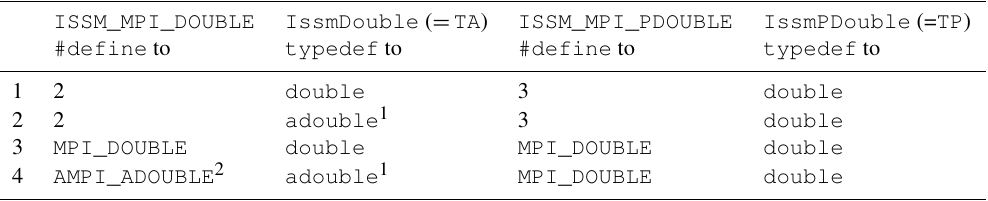
Table 2. Types per variant from Table 1.